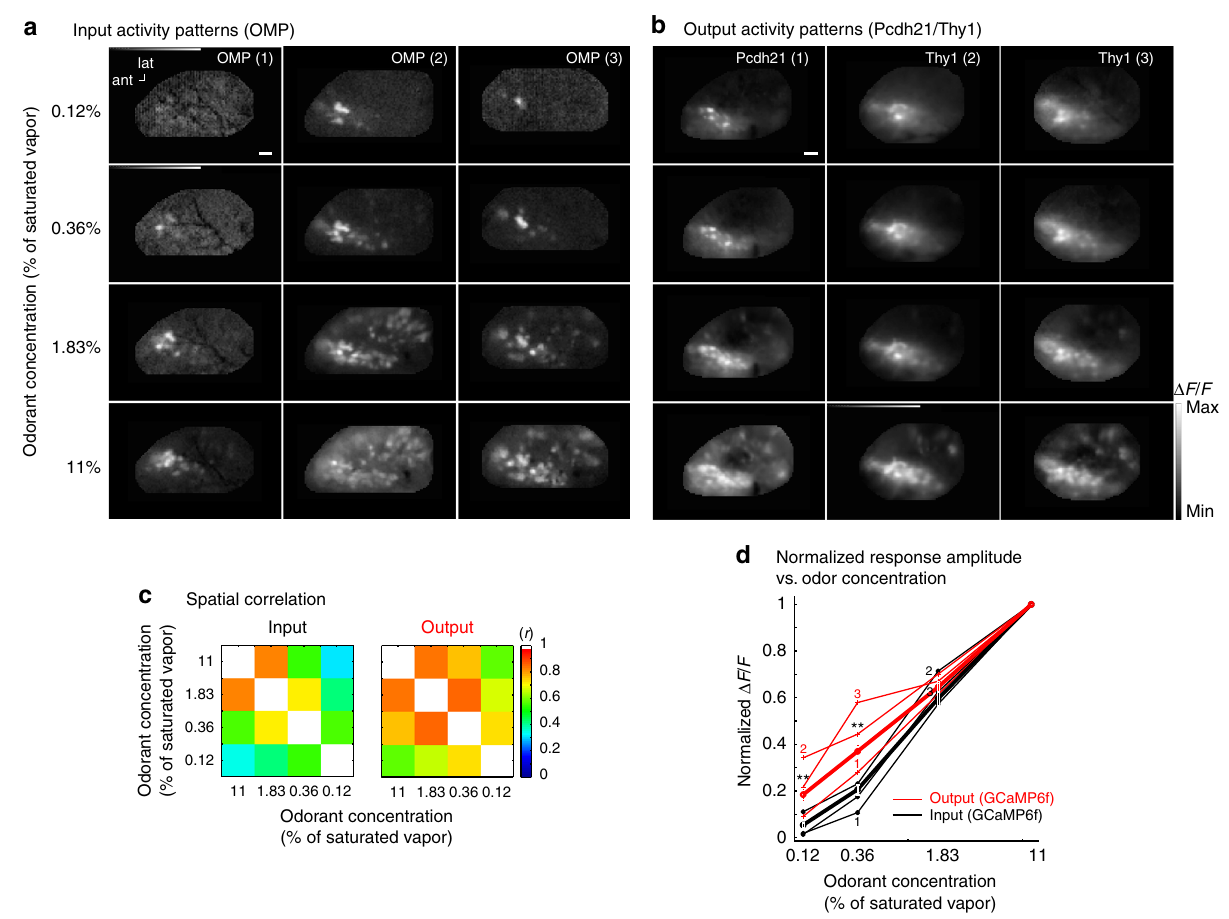
Fig. 4 Comparison of GCaMP6f in input and output in separate preparations. a Frame subtraction maps of activity from three different preparations expressing GCaMP6f in the input olfactory receptor neurons (OMP-GCaMP6f mice). The largest glomerular signals ( Δ F / F ) for each preparation are from low to high concentration ( left ) 0.6%, 2.6%, 5.6%, 10%; ( middle ) 4%, 5.9%, 9%, 11%; ( right ) 1.2%, 4.4%, 6.5%, 7.2%. b Frame subtraction maps of